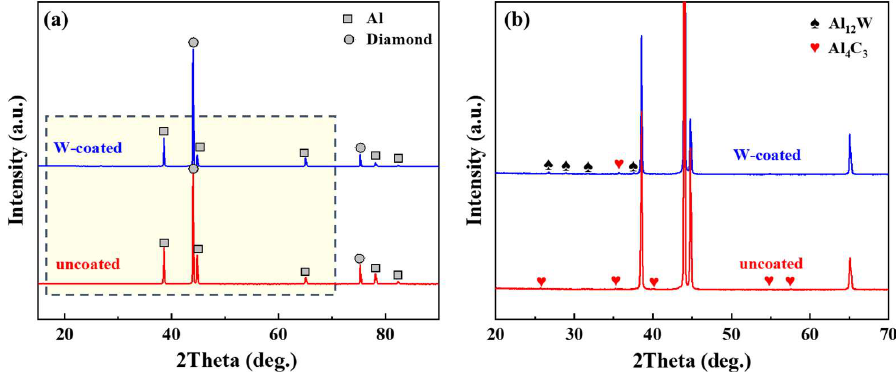
Figure 2. XRD pattern of diamond/aluminum composite: ( a ) Total; ( b )